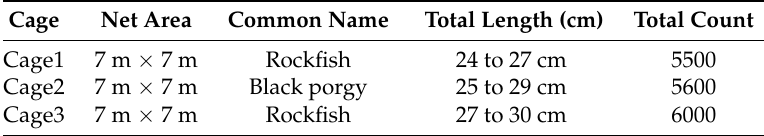
Figure 2. An experiment performed on a cage using Simrad EK15. Table 3. Details of all the three fish cages used in the